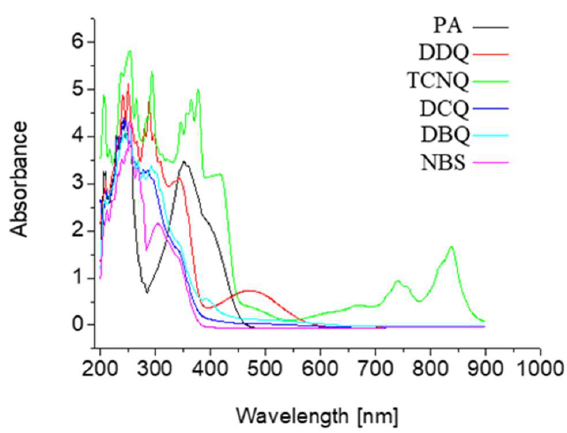
Figure 3. UV-Vis spectra of the TZD charge transfer complexes with the six π-acceptors. In the infrared spectra of free TZD, there are distinctive bands at 3000, 2954, 1704, 1650, 1600, 1350, and 750 cm −1 , which are vibrating bands extended to C- Haromatic , C-H aliphatic , C=O, C=N, and C=C, C–N, and C–Cl, respectively. The IR spectra of the TZD drug with six π-acceptors are shown in Figure 4. Figure 4. IR spectra of the ligand-acceptors complexes. IR spectra of the ligand-acceptor complexes revealed a combination of basal bands typical of both the TZD donor and an individual acceptor (Figure 4). The connection of intermolecular charge transfer complexes between the donor and acceptor was confirmed and supported by these findings. Small shifts in the donor and acceptor band intensities and wave values in TZD complexes rather than the molecules of the free reactants are due to the expected changes in the reactants’ molecular symmetries and electronic structures upon complexing. The v(C=N) and (C=C) vibrations of TZD alone are seen at 1650 and 1600 cm −1 , respectively, however, these bands are displaced to lower wave numbers at 1627 and 1553 cm −1 in the case of the PA charge transfer complex. This is supported by the fact that the n–π* and π–π* molecular charge transfer complexes are located as indicated in Figures 4 and 5.